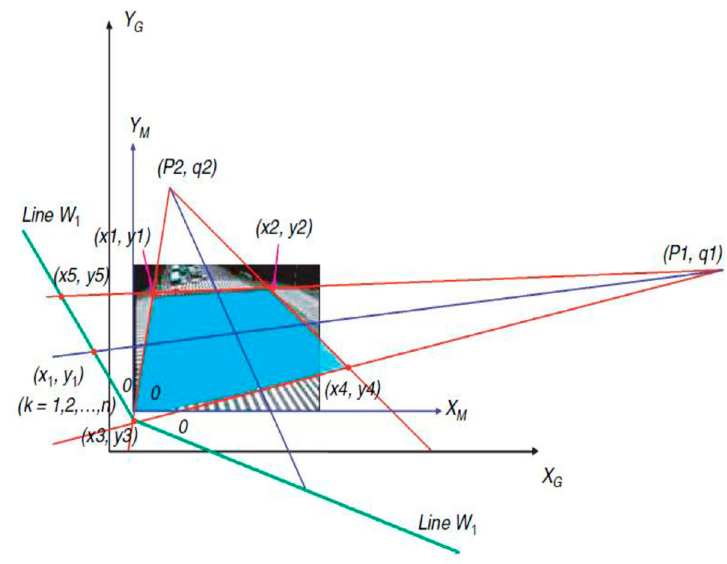
Figure 7. Applying the algorithm developed in this study to an intersection.